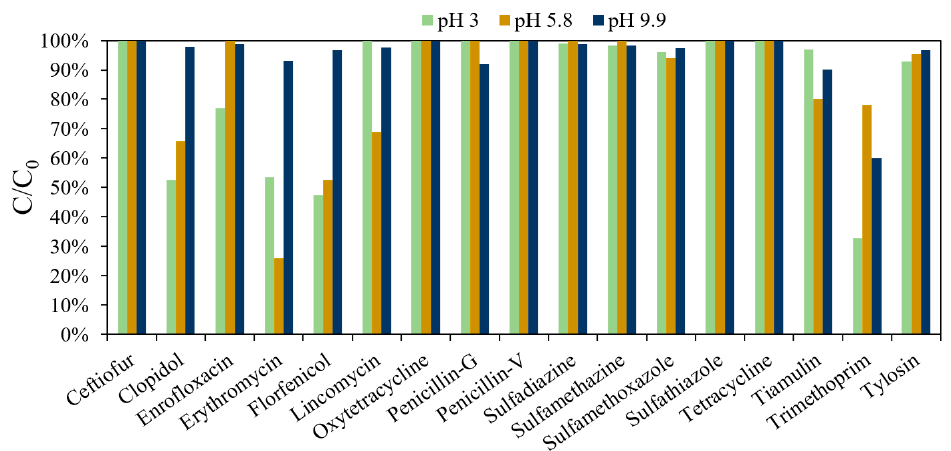
Figure 7. Degradation efficiency of antibiotics at different solution pH. [antibiotics] 0 = 50 µ g/L, [TiO 2 ] 0 = 0.1 g/L.